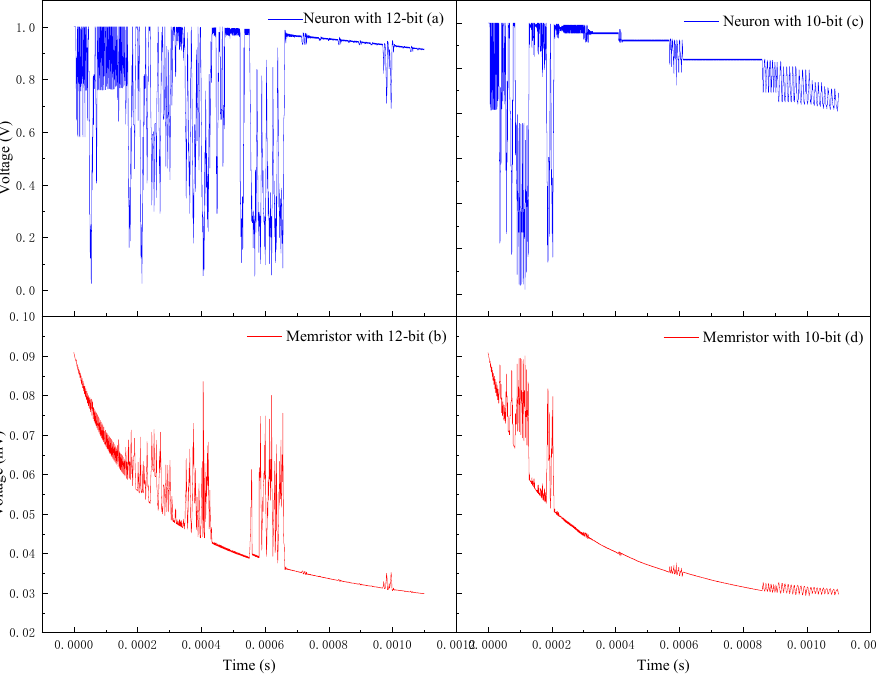
Figure 8. Hardware simulation results. ( a ) and ( b ) are the output voltage of the neuron and memristor with 12-bit ADC/DAC, respectively; ( c ) and ( d ) are the output voltage of the neuron and memristor with 10-bit